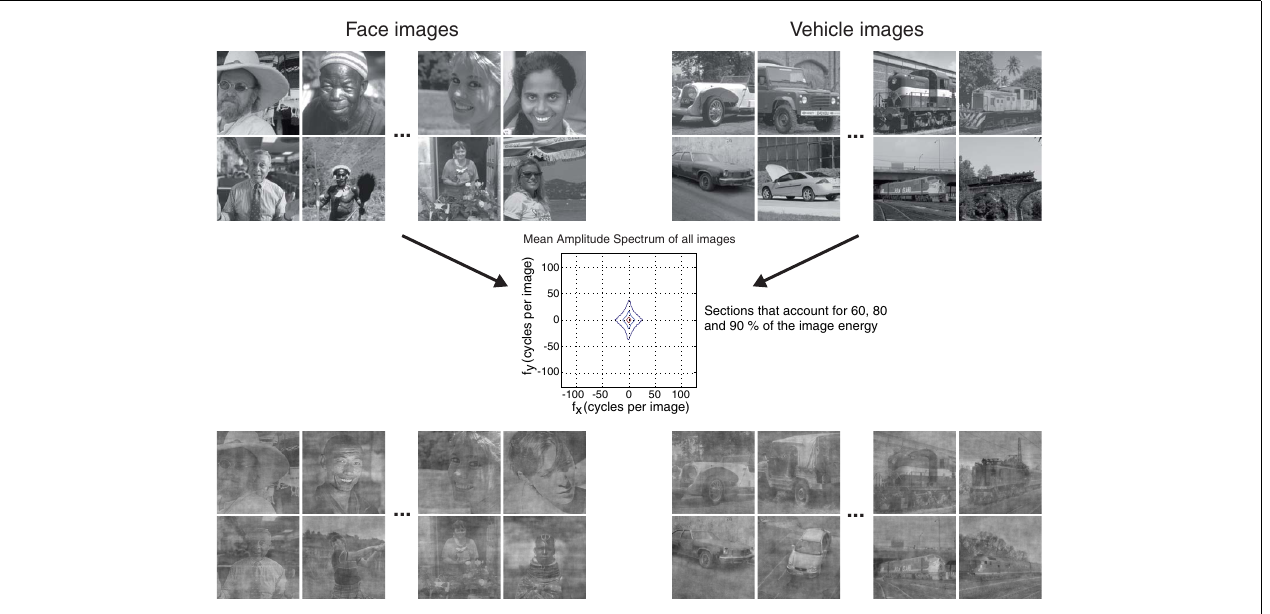
account for 60, 80, and 90% of the image energy.This mean amplitude spectrum was then applied to every image to create the normalized condition. Examples of images for this condition are at the bottom of the figure.